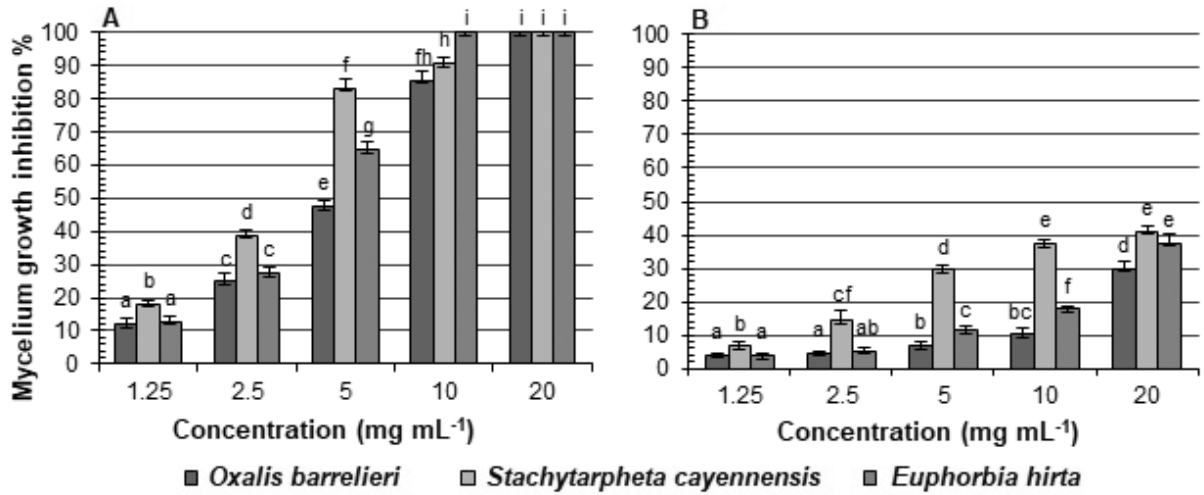
Figure 4. Mycelium growth inhibition of Rhizoctonia solani at 1.25, 2.50, 5, 10 and 20 mg mL -1 concentrations of the ethanol extracts (A) and water extracts (B) from three plant species. Data are means ± standard deviation from three experiments, each with five replicates. At each concentration, the means accompanied by different letters are significantly different, according to ANOVA paired with Tukey’s tests ( P ≤